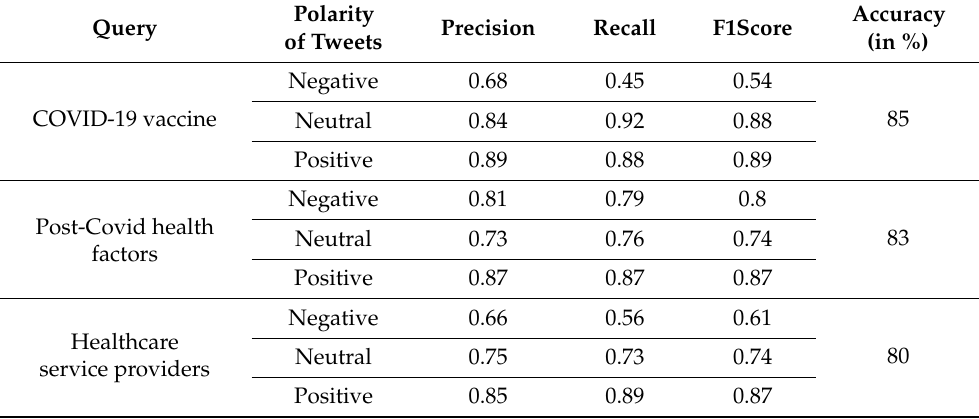
Table 4. SVM model evaluation results for all three considered queries. Polarity Query of